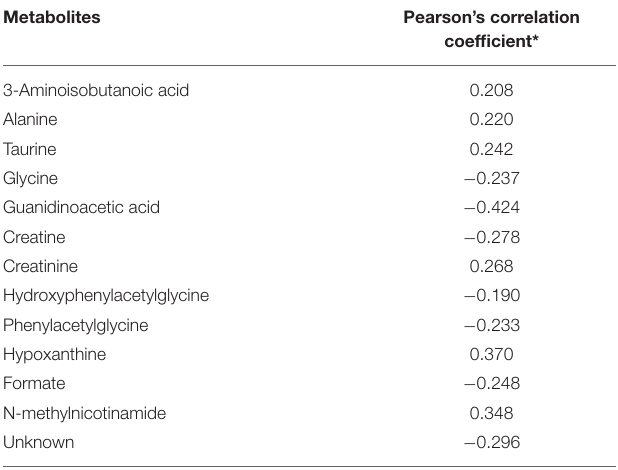
FIGURE 5 | Comparation of the fold changes of the differential metabolites between the ASD and control groups. The fold change represents the ratio of average peak area between ASD group and control